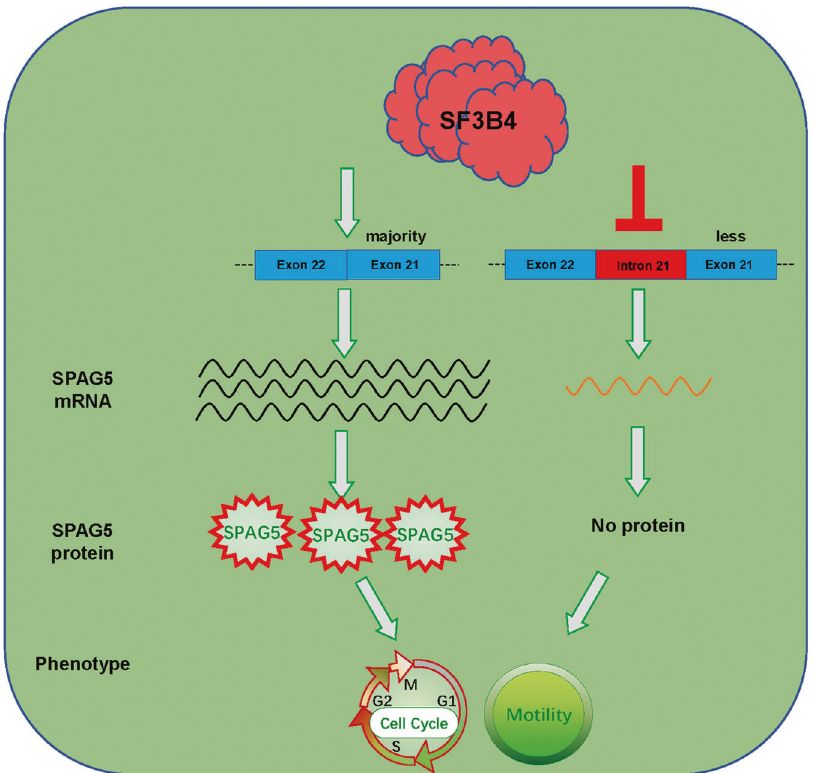
Fig. 8 Model showing the effect of SF3B4/SPAG5 signaling on the malignancy of cervical cancer cells. The splicing factor SF3B4 drives malignant behavior in cervical cancer by regulating the normal splicing of SPAG5. When SF3B4 is de fi cient, SPAG5 splicing becomes abnormal and its expression is